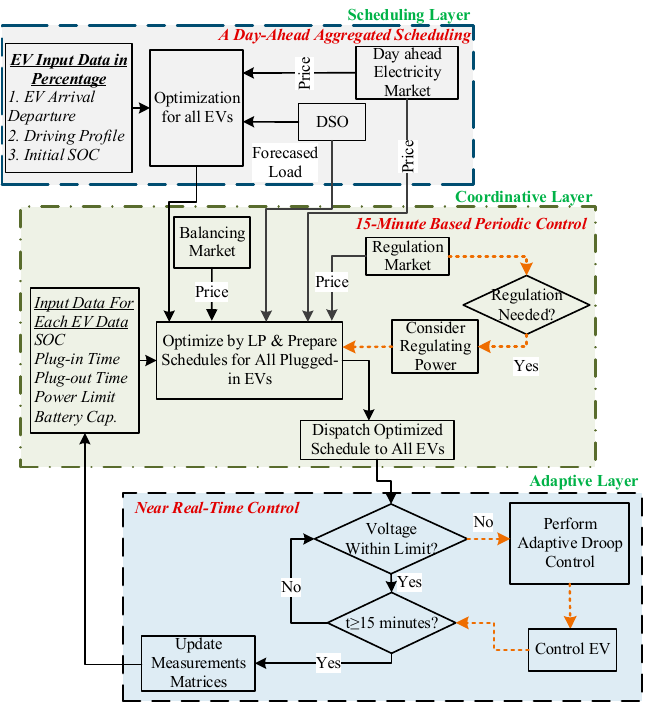
Figure 6. Block diagram of the hierarchical control architecture (HCA) operation. SOC : state-of-charge; AND LP: linear programming.